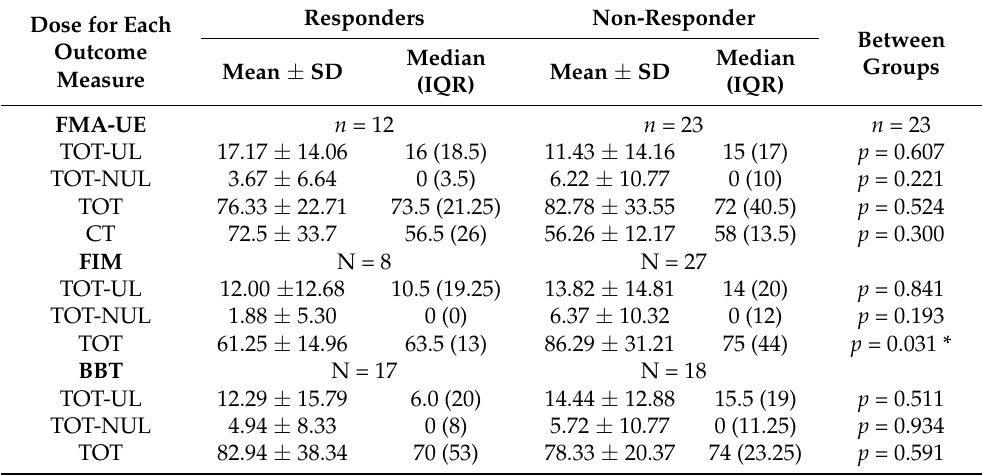
Table 5. Comparison between dose (hours) of rehabilitation between Responders and Non- Responders for UL motor